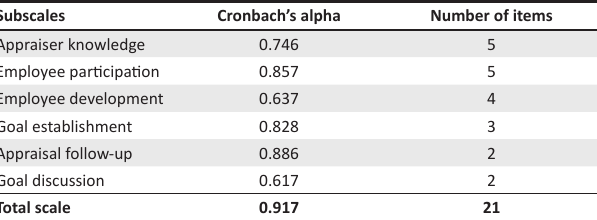
TABLE 2: Cronbach’s alpha for the six subscales of the performance appraisal fairness scale.